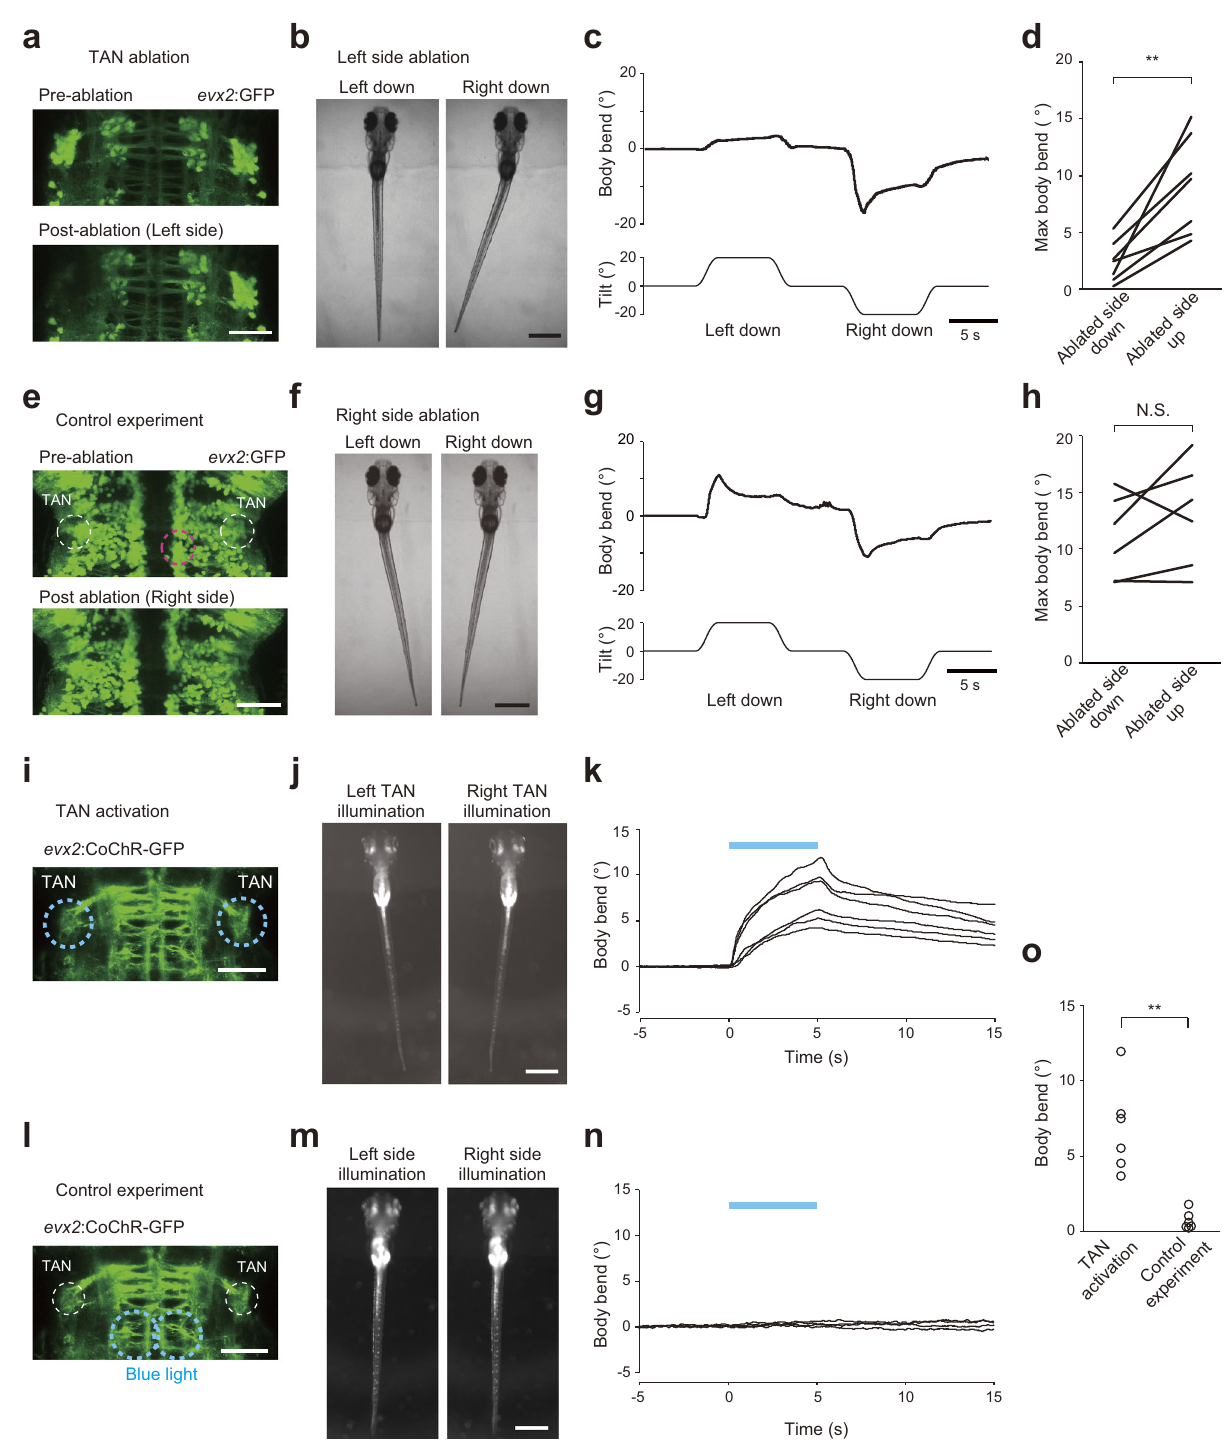
#5, and #10 in Fig. 6b). Among all the nMLF neurons examined from ten fi sh ( n = 330), approximately one-third of the neurons were obviously active when fi sh were tilted in the ipsi-up direction (red, orange, yellow, and white color in the pseudo-colored image in Fig. 6c). This conspicuous ipsi-up (contra-down) activity was con- sistent with our hypothesis, which is shown in Fig. 3 (note that nMLF neurons receive commissural axonal projections from the excitatory TAN neurons). During ipsi-down tilt, in contrast, slight decreases in Δ R/R 0 occurred in many nMLF neurons (the dark blue color becomes more blackish in the pseudo-colored image in Fig. 6c). This